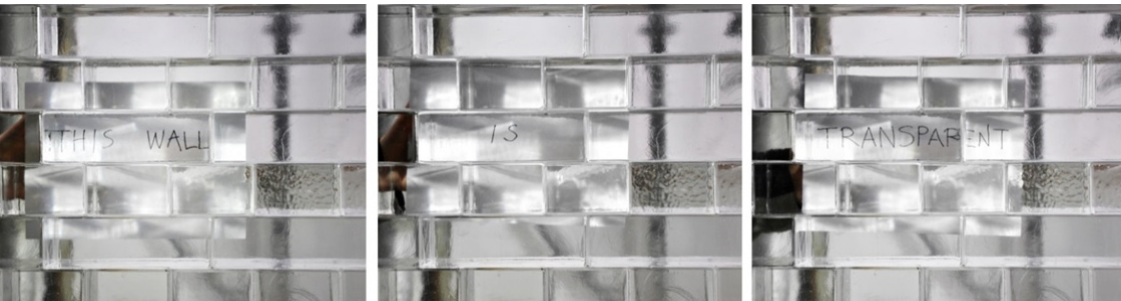
Fig. 15 Transparency level of the wall.